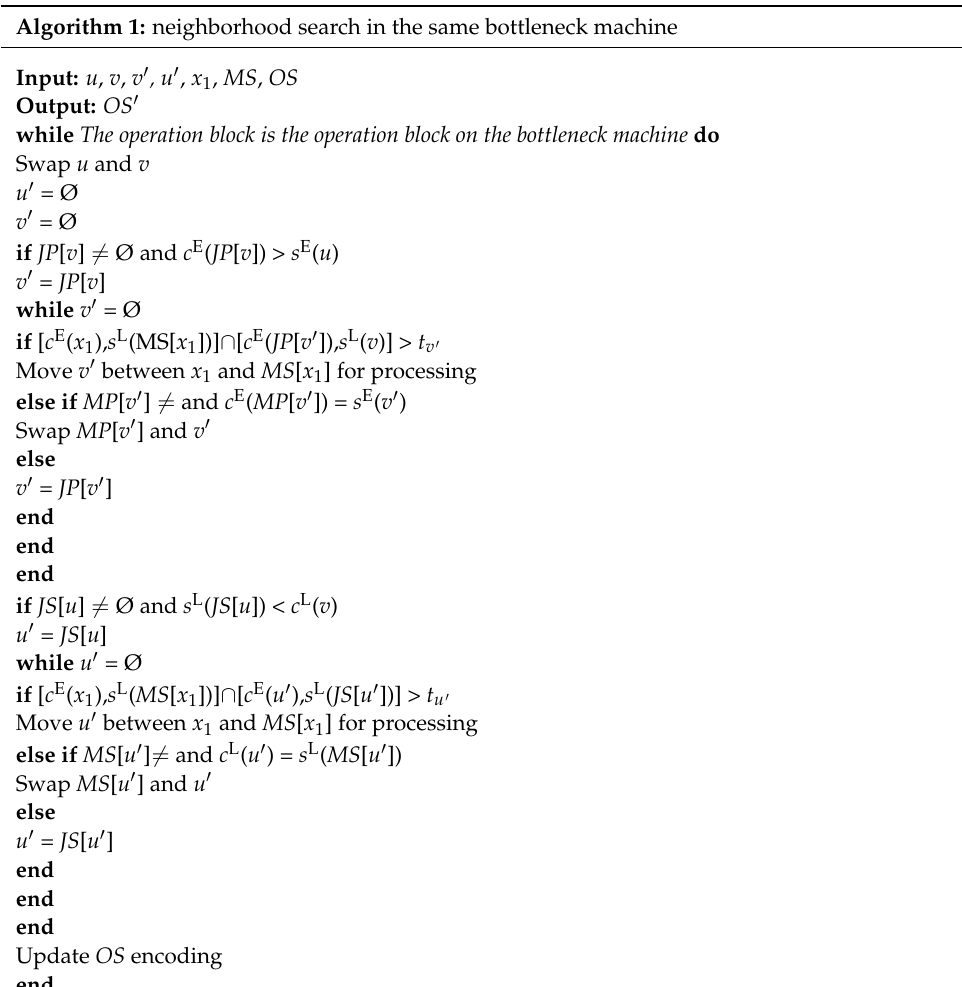
Algorithm 1: neighborhood search in the same bottleneck